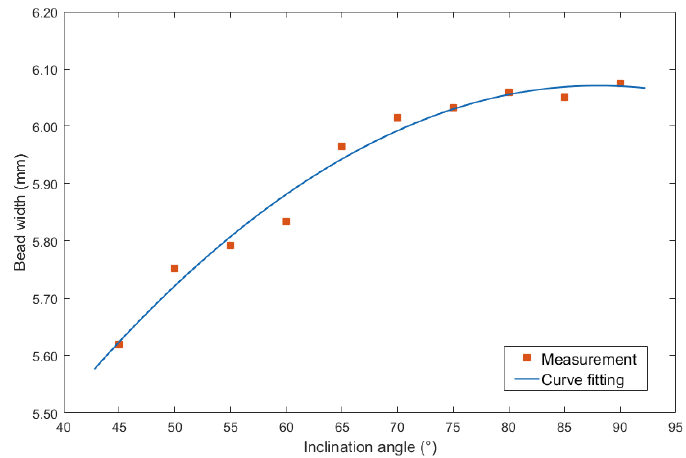
Figure 7. Curve fitting between forward inclination angle and bead width.